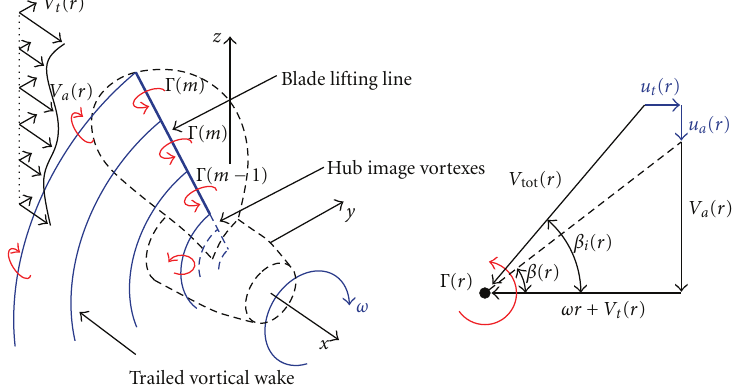
Figure 1: Blade equivalent lifting line, reference system, and velocities